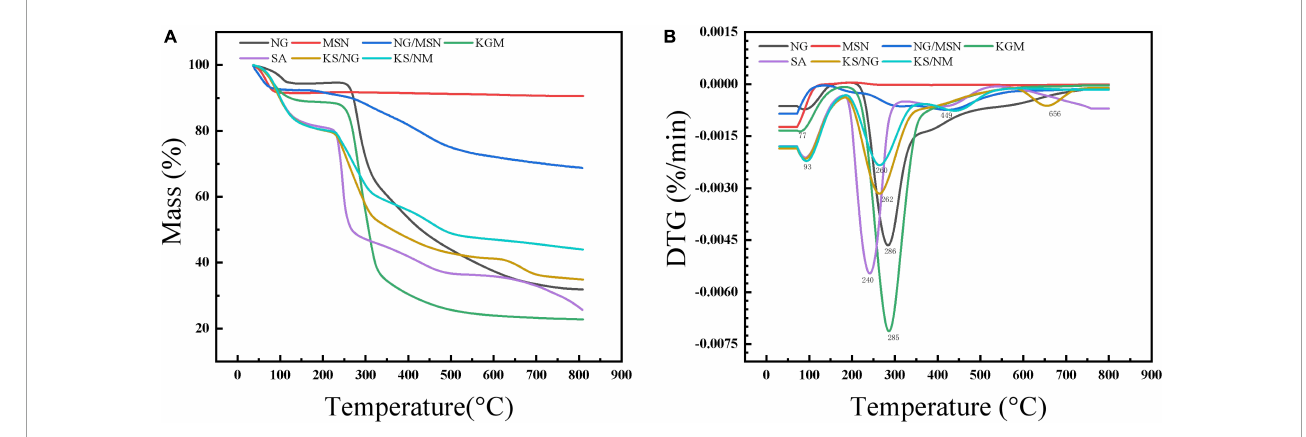
FIGURE7 TGA curves (A) and DTG curves (B) of NG, MSN, NG/MSN, KGM, SA, KS/NG, and